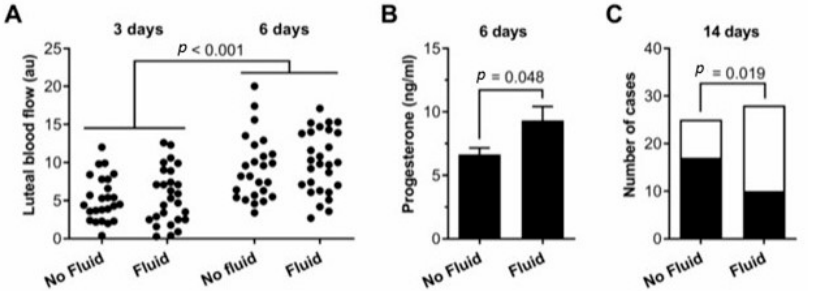
Figure 2. IUFA increase progesterone and reduces per cycle pregnancy rates. ( A ) Dot plot of blood flow 3 and 6 days after ovulation, in cases with IUFA or not, after insemination, with each dot representing an independent case (n = 53). Data were analyzed by ANOVA, and p values were reported. ( B ) Plasma progesterone concentrations 6 days after ovulation in cases with IUFA (n = 28) or without IUFA after insemination (n = 25). Data are presented as mean (SEM), and were analyzed by independent t -test. ( C ) Frequency of cases that resulted in pregnancy ( (cid:4) ) or not ( (cid:3) ), with data compared using Pearson’s Chi-squared test. IUFA: intrauterine fluid accumulation.